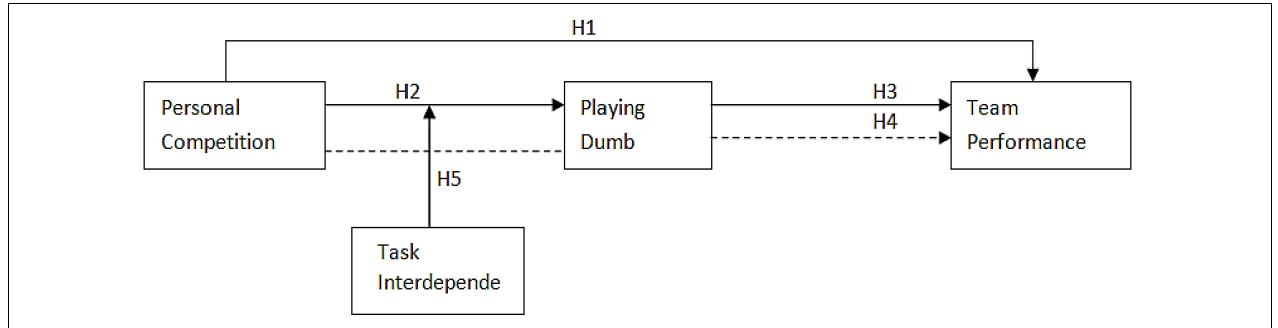
FIGURE 1 | Theoretical framework. PC, personal competition; PD, playing dumb; TP, team performance.